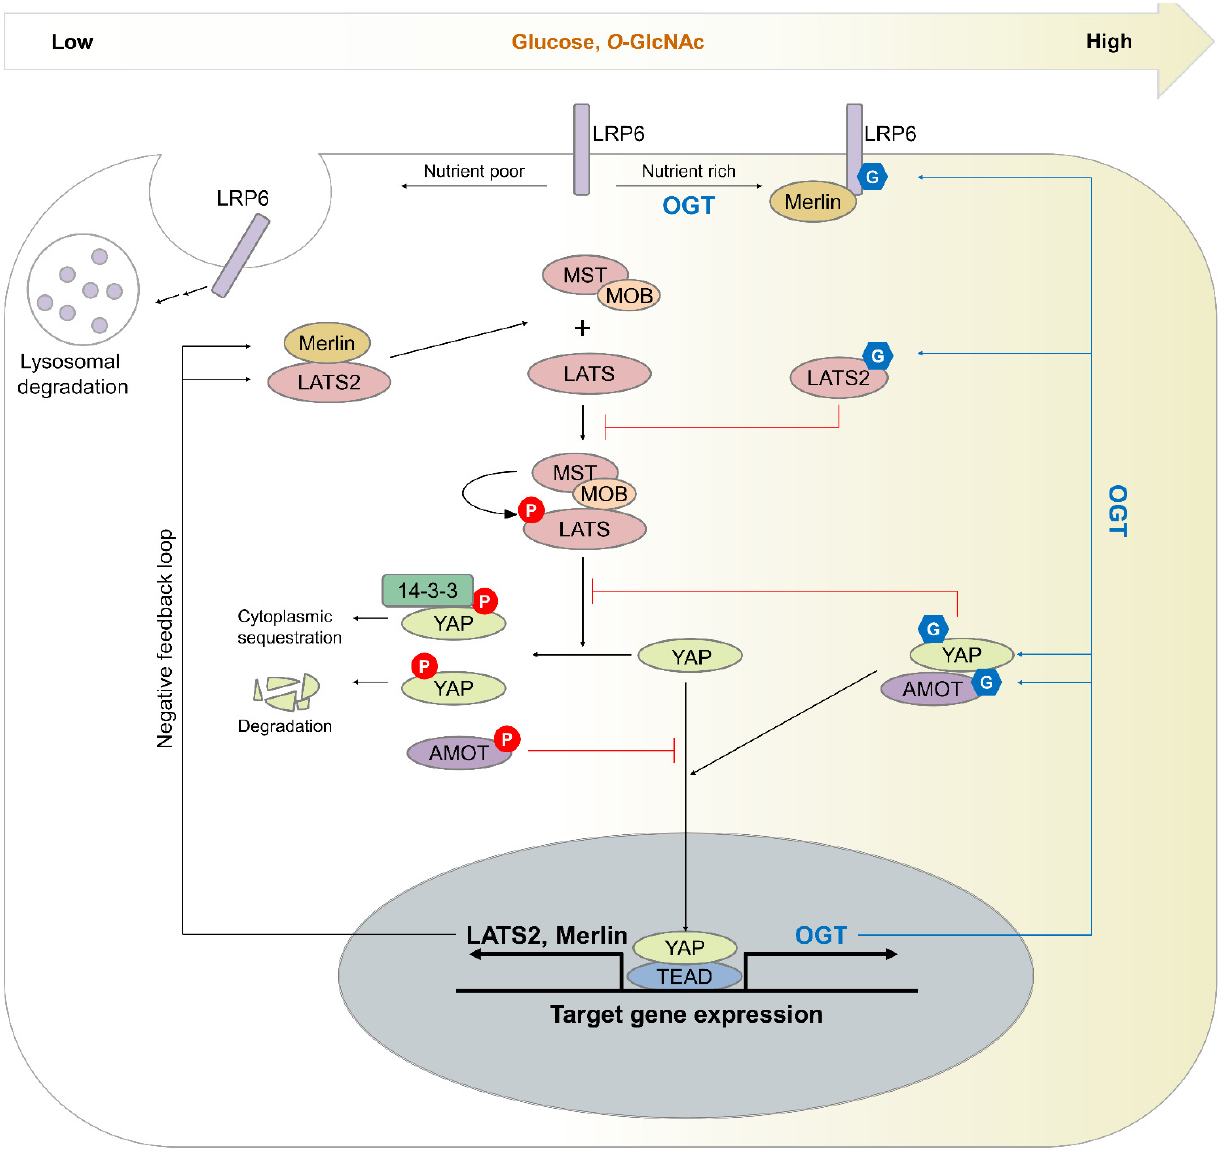
Figure 4. Mechanism by which O -GlcNAcylation constantly attenuates the Hippo pathway through mutual regulation. The O -GlcNAcylation of specific proteins, such as LRP6, LATS2, YAP, and AMOT, increases the activity of the Hippo pathway effector YAP. LRP6 O -GlcNAcylation may diminish LATS activity by decreasing Merlin–LATS interactions through the inhibition of the lysosomal degradation of LRP6. LATS2 O -GlcNAcylation inhibits its activity by interrupting the MOB1–LATS2 interaction. YAP O -GlcNAcylation induces its activity by disturbing the interaction with LATS1. AMOT O -GlcNAcylation may cause the nuclear accumulation of YAP by decreasing AMOT phosphorylation at Ser175. Hyperactivated YAP induces the gene expression of LATS2, Merlin, and OGT. LATS2 O -GlcNAcylation blocks the Hippo pathway negative feedback loop caused by YAP-mediated LATS2/Merlin gene expression by blocking MOB1-LATS2 interactions. As a result, abnormally increased O -GlcNAcylation induces Hippo pathway dysregulation and sustains aberrant hyper- O -GlcNAcylation.